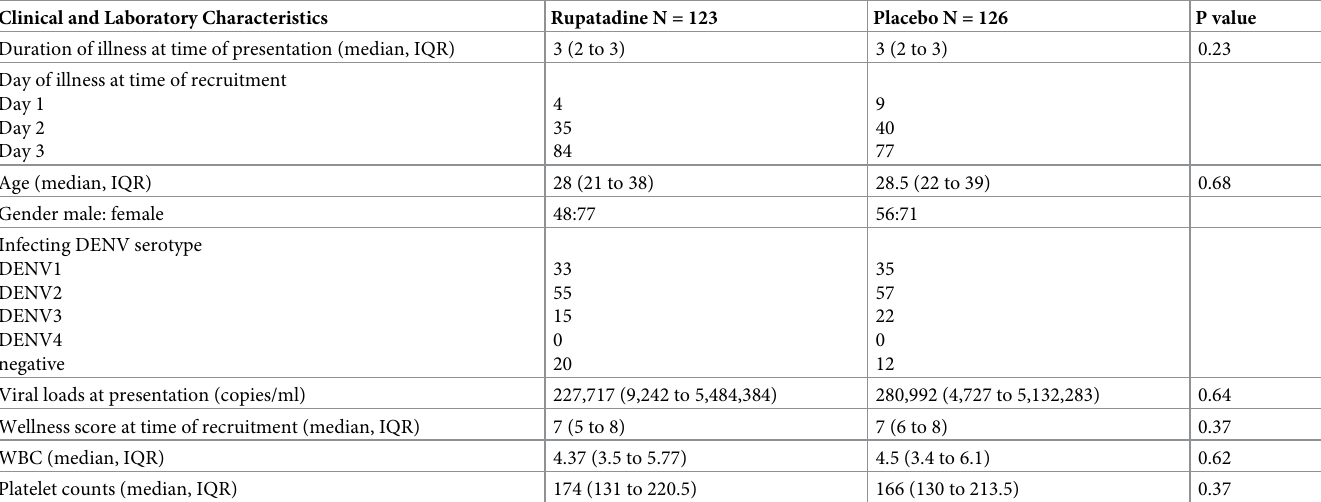
Table 1. The baseline characteristics of those who were recruited to receive either 40mg of rupatadine daily for 5 days or the placebo for 5 days. Clinical and Laboratory Characteristics